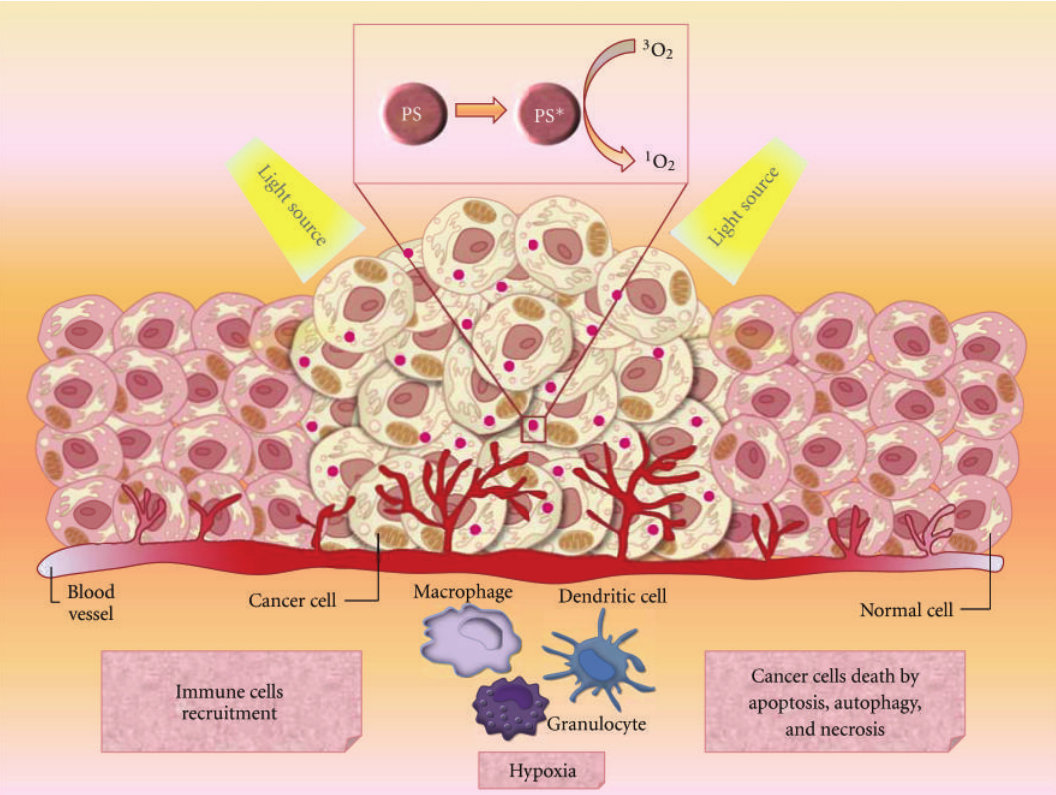
Figure 1: The mechanism of PhotoDynamic Therapy action on cancer cells. Upon irradiation with visible light of a specific wavelength, the Photosensitizer (PS) is excited from a ground state to an excited state, which transfers its energy to tissue ground state triplet oxygen producing singlet oxygen ( 1 O 2 ), a very reactive chemical specie able to destroy a tumour by multifactorial mechanisms. PDT can directly trigger tumour cells death by induction of apoptosis, autophagy, and necrosis, damage the vasculature, induce hypoxia, and rapidly recruit immune cells, such as macrophages, dendritic cells, and granulocytes.